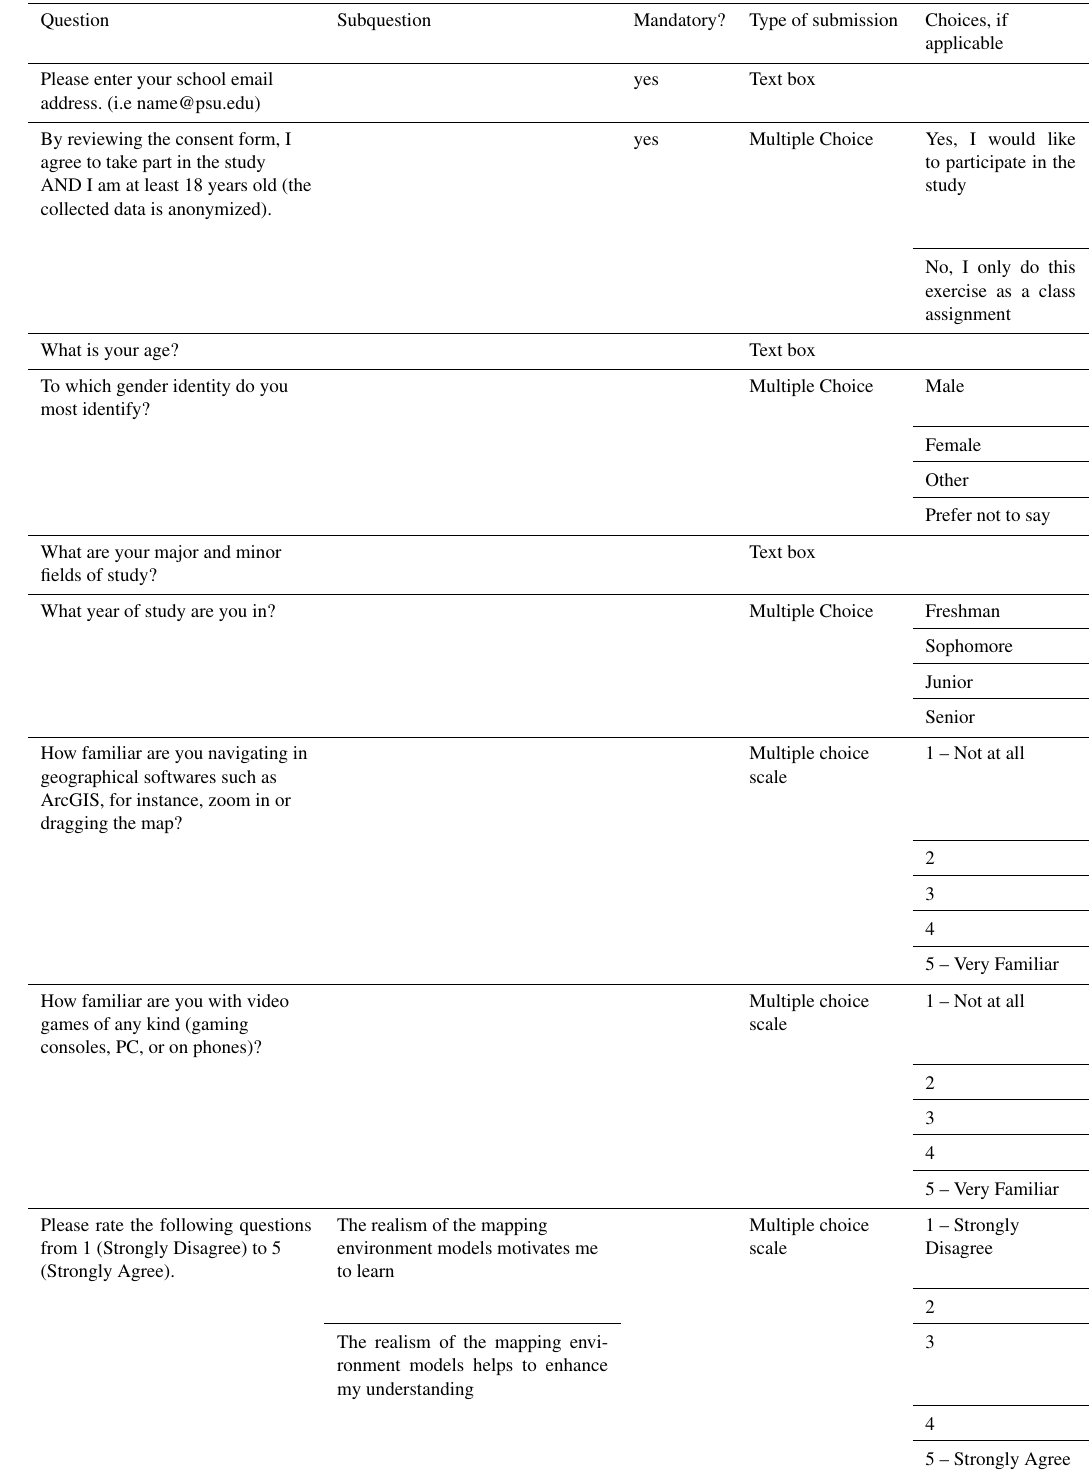
Table A1. Questionnaire used to evaluate participant demographics and experiences with the Strike and Dip